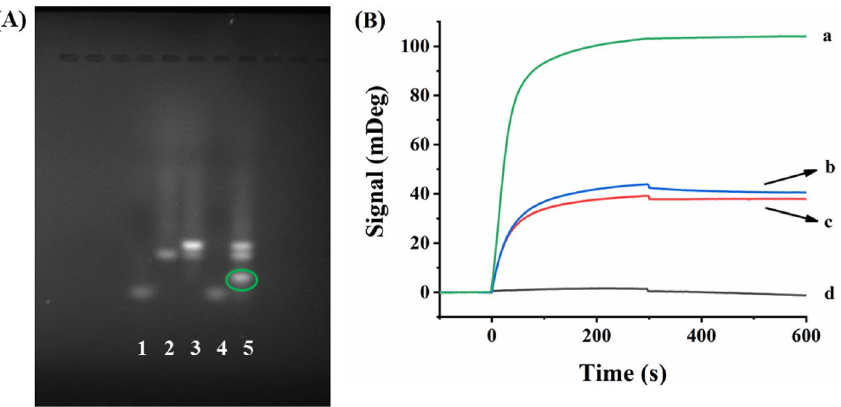
Figure 2. ( A ) Gel electrophoresis characterization of the TSDR. Lane 1: 2 μM blDNA; Lane 2: 1 μM swDNA; Lane 3: 1 μM swDNA/2 μM blDNA duplex; Lane 4: 2 μM miRNA-182; Lane 5: 1 μM swDNA/2 μM blDNA duplex + 2 μM miRNA-182. ( B ) SPR sensorgrams upon injection of 50 nM SA onto the Nb.BbvCI-treated fluidic channels that were covered with (a) trDNA + swDNA/blDNA duplex; (b) trDNA + swDNA/blDNA + miRNA- 182; (c) trDNA + swDNA; (d) non-biotinylated trDNA + swDNA/blDNA duplex + miRNA-182.